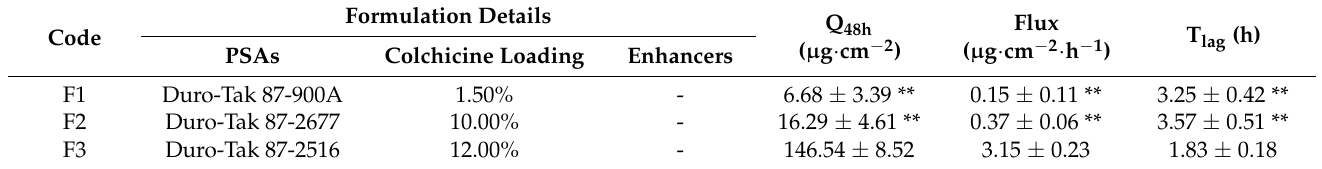
Table 2. In vitro pig skin permeation parameters of colchicine in patches containing colchicine with highest solubility in various PSAs (mean ± SD, n = 6).